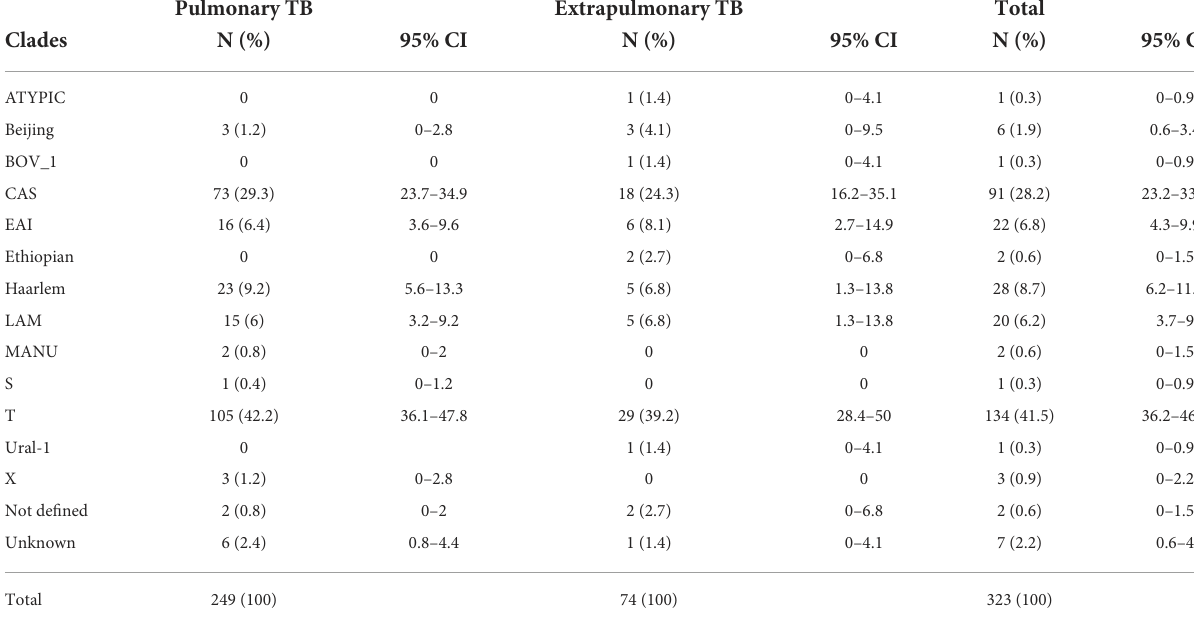
TABLE 2 Distribution of spoligotype clades between pulmonary and extrapulmonary TB patients in Somali region,